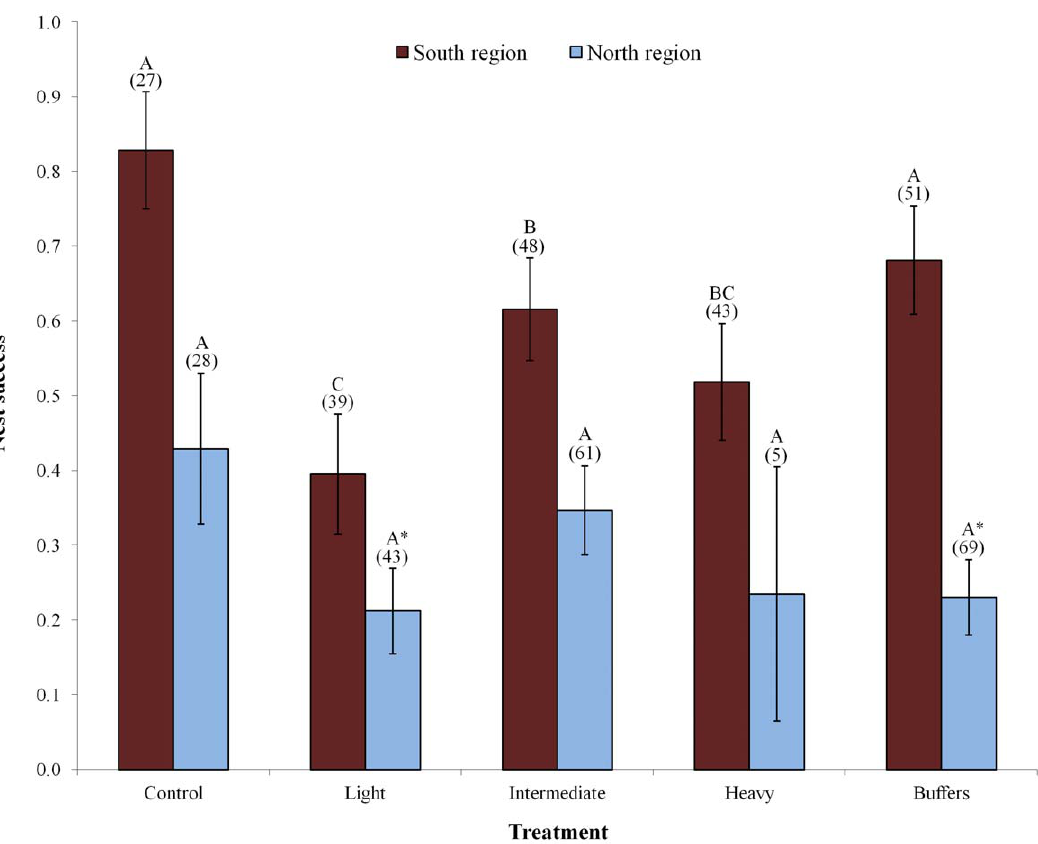
Figure 5. Cerulean warbler nest success by treatment and region, 2008–10. Different letters indicate significant differences ( P # 0.05) between respective treatments within a region (based on CONTRAST x 2 test). Asterisks indicate marginal differences (0.05 , P # 0.10) between respective treatments and controls within a region. Markings above buffer columns refer only to their relationship with controls. Error bars represent 6 1 SE and numbers above bars indicate nest sample sizes.